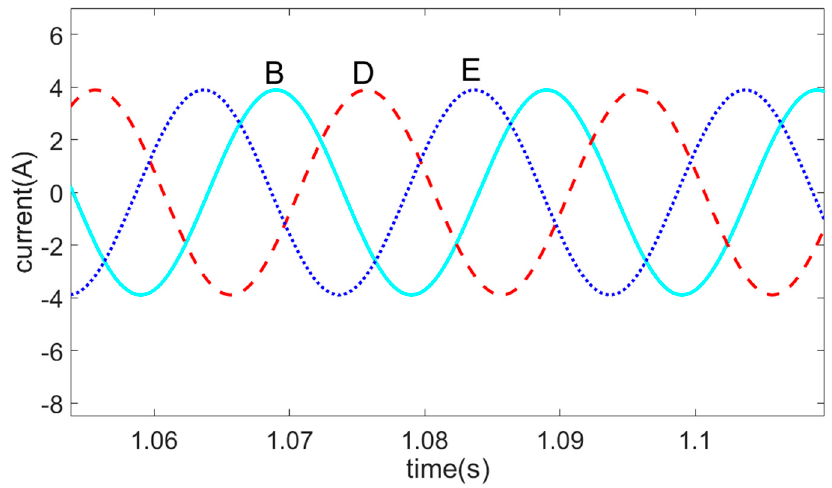
Figure 9. Schematic diagram of remaining threephase currents after fault − tolerant control in case of open − circuit fault of phase A and C.